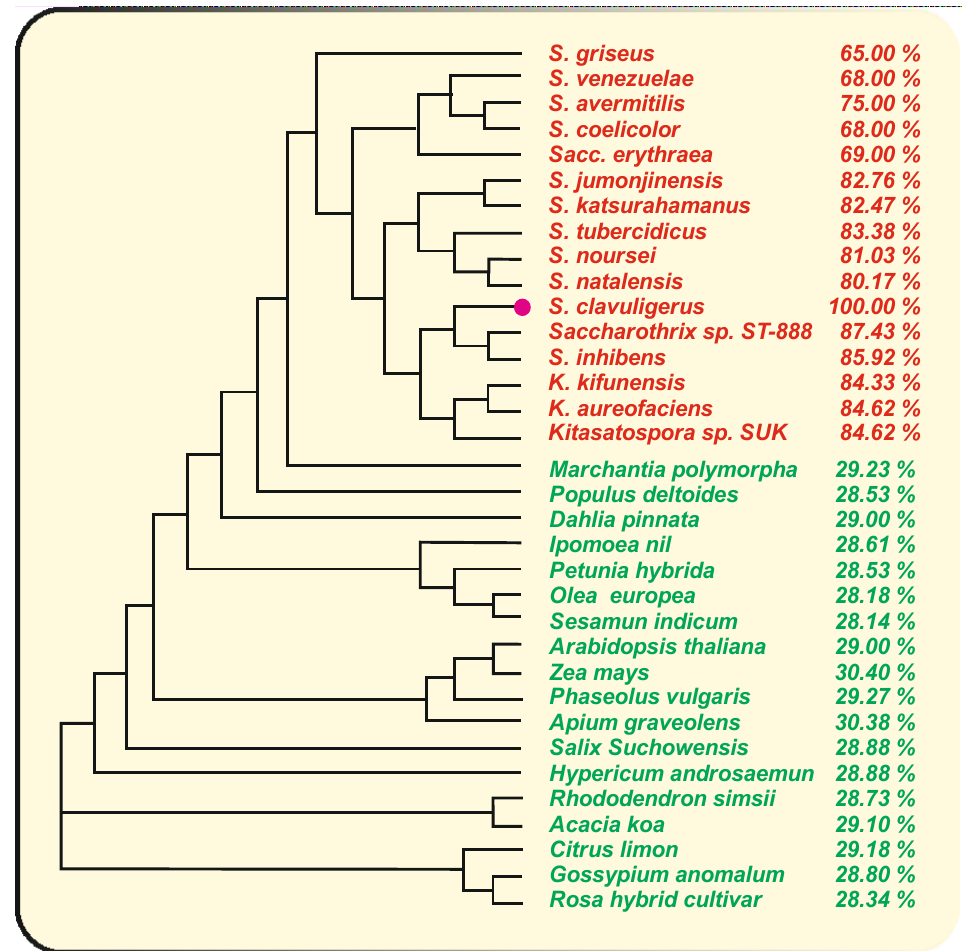
Figure 3. Phylogenetic three of chalcone synthases of actinobacteria (red colour) and plants (green colour). The name of the organism is indicated at the right side of its location in the phylogenetic tree and the identity percentage of each CHS to S. clavuligerus Ncs is indicated. The accession num-